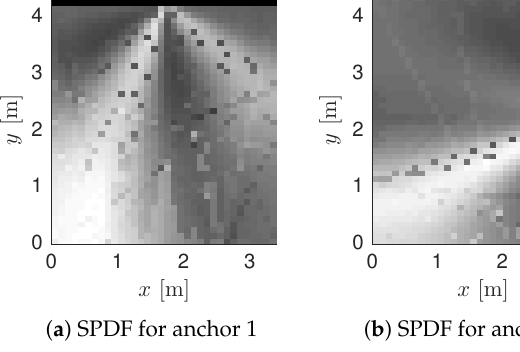
Figure 9. Example of two merged SPDF vectors.